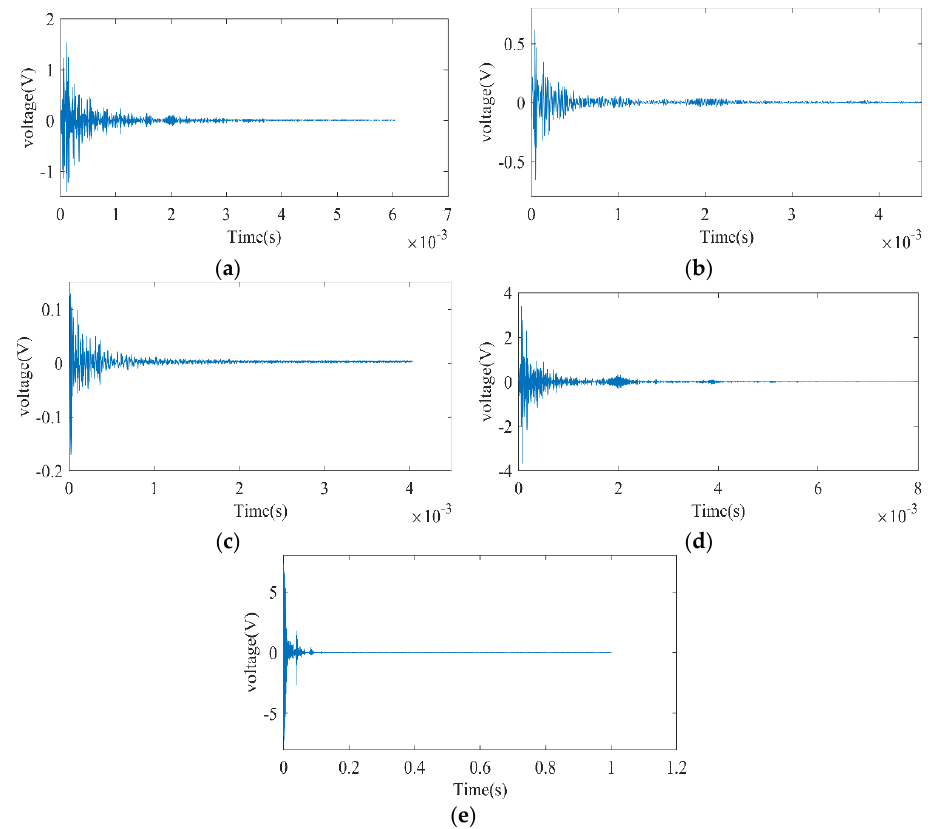
Figure 7. Segmented acoustic emission signal. ( a ) Signal 1; ( b ) Signal 2; ( c ) Signal 3; ( d ) Signal 4; ( e ) Signal 5.